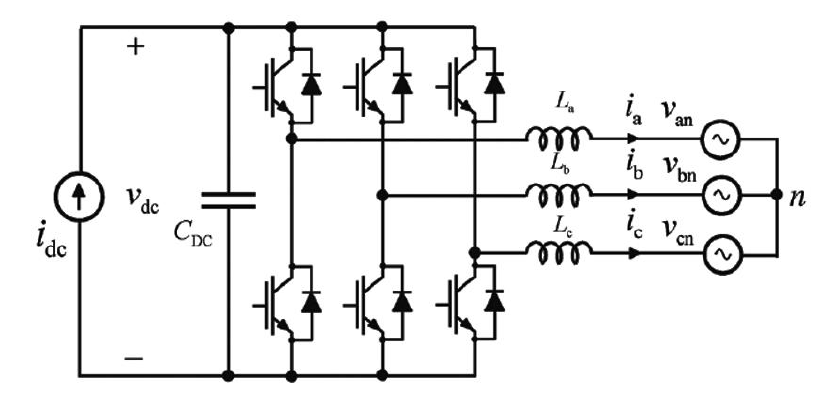
Figure 2. Grid-connected PV system model.